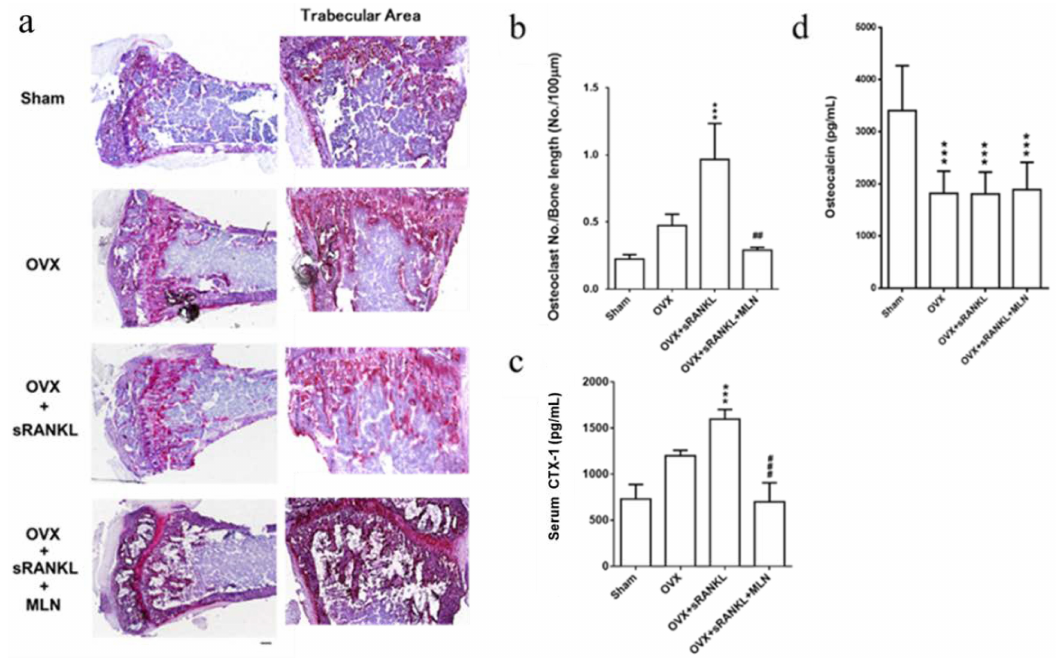
Figure 7. Histologic and immunohistochemical studies of the uncalcified bone section of the proximal tibia. ( a ) Hematoxylin- and TRAP-stained sections of tibial metaphyses from sham, ovariectomy (OVX), OVX and soluble receptor activator of nuclear factor- κ B ligand (sRANKL), and OVX and sRANKL and MLN4924 (MLN) mice. ( b ) Osteoclast number per bone length. ( c ) The serum level of CTX-1 and osteocalcin ( d ) was measured using specific ELISA in the Sham, OVX, OVX and sRANKL, and OVX and sRANKL and MLN groups. Values are the mean ± S.D (6 mice per group). *** OVX and OVX and sRANKL compared with sham, p < 0.001; ## compared with OVX and sRANKL, p < 0.01; ### compared with OVX and sRANKL, p <